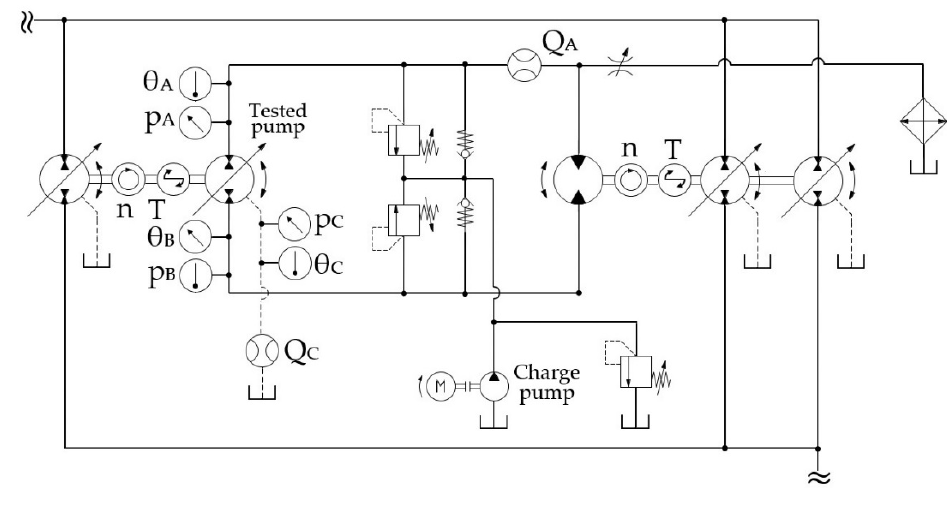
Figure 10. Hydraulic schematic of the test rig. Table 3. The operating conditions considered in this